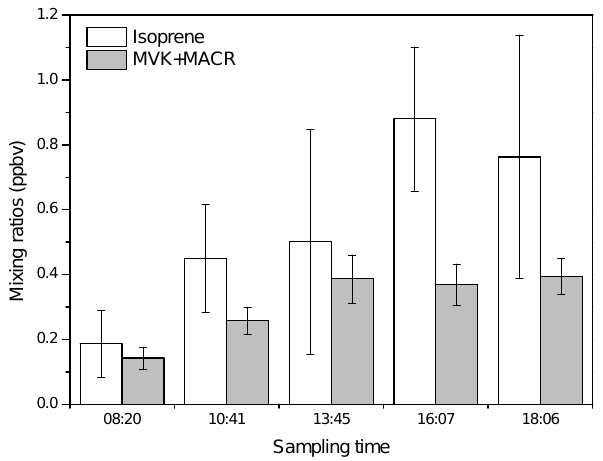
Fig. 10. The mean mixing ratios of isoprene and MVK+MACR during flights 4–8 conducted on 10 August 2012. The error bars indicate 1 standard deviation for each